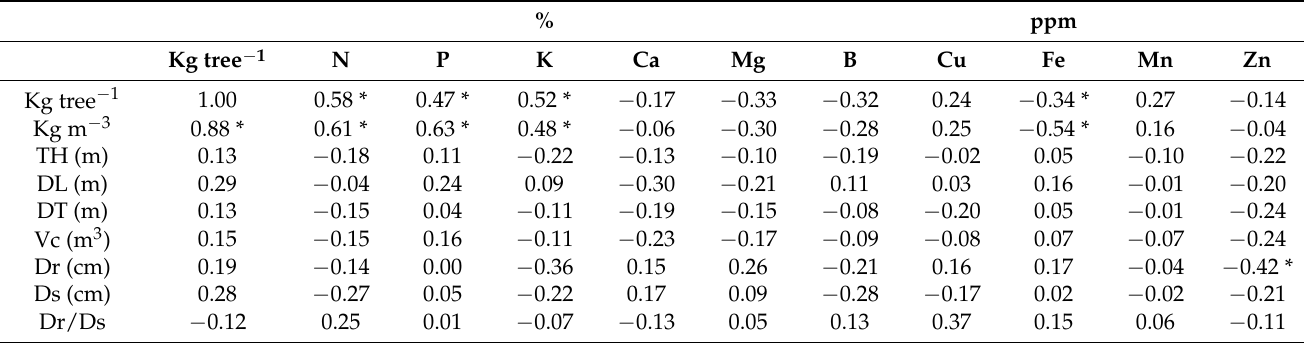
growth with leaf Ca content. Table 2. Pearson’s simple correlation among tree height (TH), tree canopy spread [canopy diameter longitudinal (DL) and transverse (DT) to the tree line], trunk diameters [trunk diameter of the rootstock (Dr) and of the scion (Ds)], rootstock–scion affinity (Dr/Ds), yield, yield efficiency, and leaf nutrient contents in ‘Lane Late’ navel orange trees on six citrus rootstocks over the 2009/2010 and 2011/2012 seasons.